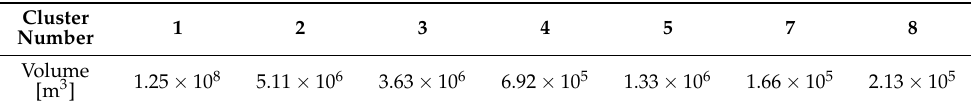
Table 2. Volumes of structures identified as possibly